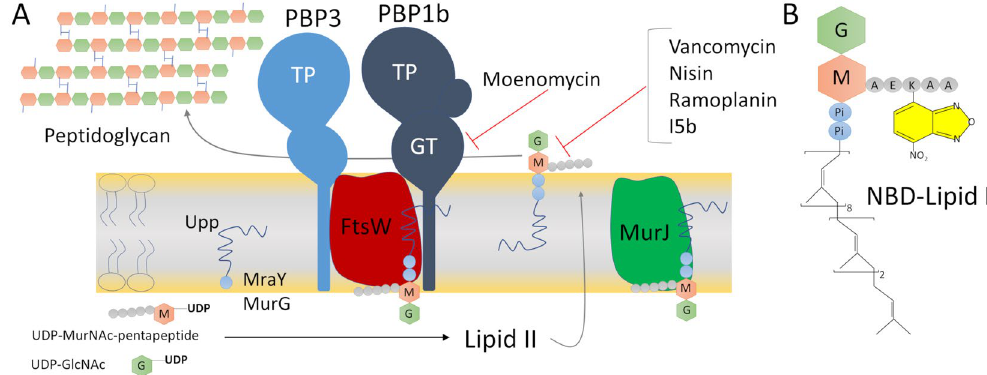
Figure 1. Schematic representation of the late stages of peptidoglycan synthesis. ( A ) The lipid II precursor is assembled at the inner face of cytoplasmic membrane by MraY and MurG from soluble precursors (UDP- MurNAc-pentapeptide and UDP-GlcNAc) and the undecaprenyl-phosphate (Upp) lipid carrier. Lipid II is then transported to the outer face of the membrane by MurJ/FtsW where it is polymerized by FtsW and PBPs. The mode of action of the antibiotics are indicated with red lines. ( B ) Structure of the fluorescent NBD-labeled lipid II. Upp is attached to the disaccharide MurNAc-GlucNAc via a pyrophosphate (Pi-Pi). AEKAA depicts